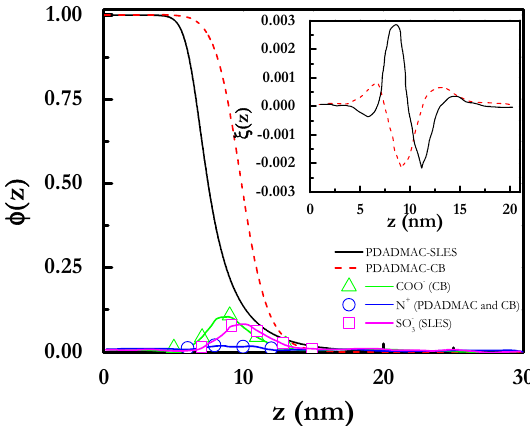
Figure 4. Radial volume fraction ( ϕ ( z )) profiles for the inner hydrophobic core and the charged corona of polyelectrolyte–surfactant complexes. The polyelectrolyte had a length of 100 segments and a segment valence ν p = 1. The inset represents the dimensionless radial charge density ( ξ ) profiles for the complexes.